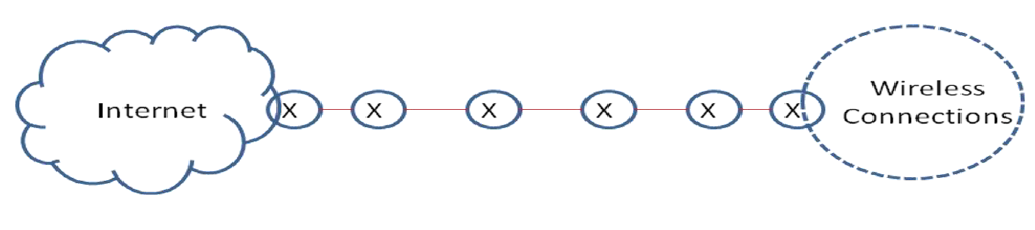
Figure 7. Simplified Route through